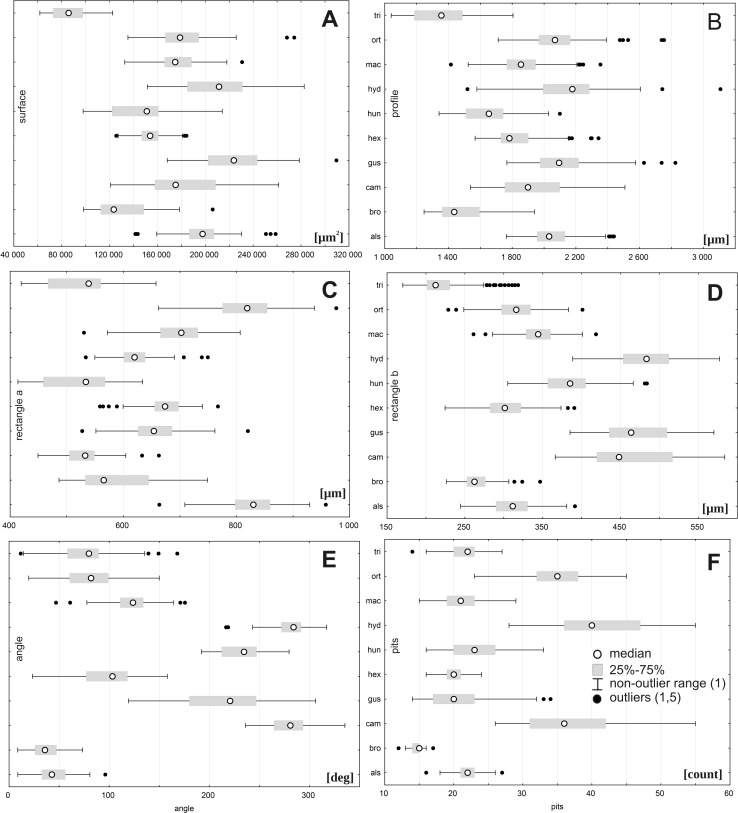
Boxplots of the most discriminative seed traits among Elatine species studied.Notations: boxes indicate 25–75 percentiles, white points indicate medians, whiskers exclude outliers, black points indicate outliers. For acronyms, see Table 1. (A) surface; (B) profile; (C) rectangle a; (D) rectangle b; (E) angle; (F) pits.